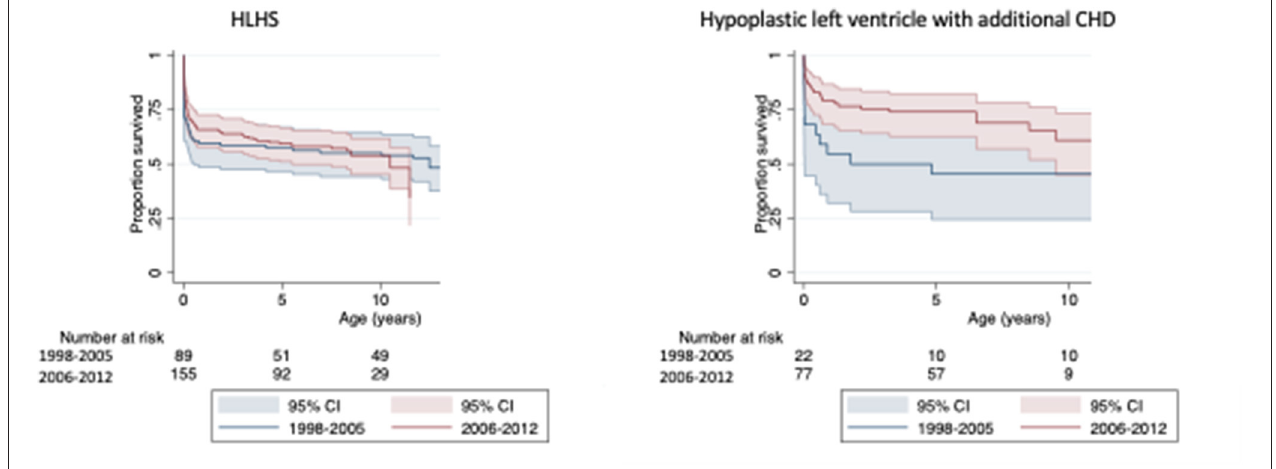
FIGURE 2 | Kaplan-Meier survival curves by year of